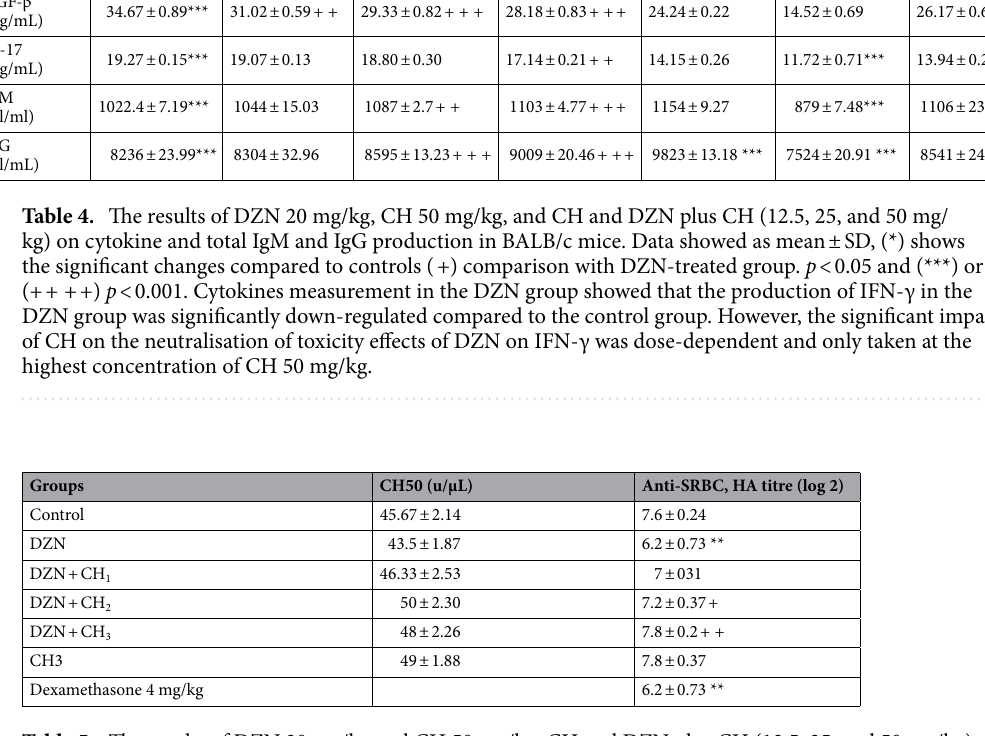
Table 5. The results of DZN 20 mg/kg and CH 50 mg/kg, CH and DZN plus CH (12.5, 25, and 50 mg/kg) on CH50 and specific Ab production in BALB/c mice. Data showed as mean ± SD, (*) shows the significant changes compared to controls, ( +) comparison with the diazinon-treated group. p < 0.05 and (***) or (+ + + +) p < 0.001. The results of the HA test showed that producing specific anti-SRBC for evaluation of humoral immunity inhibited when animals received DZN. However, CH at the highest concentration, 50 mg/kg, was able to neutralise the inhibitory effect of DZN strongly. Albite and CH at doses of 12.5 and 25 mg/kg also statistically ameliorated the toxic effects of DZN plus CH. As an immune-inhibitory drug, dexamethasone also dramatically suppressed the specific antibody production compared to the control group. Moreover, complement hemolytic activity decreased in the DZN-receiving animal, but the result was not statistically significant.